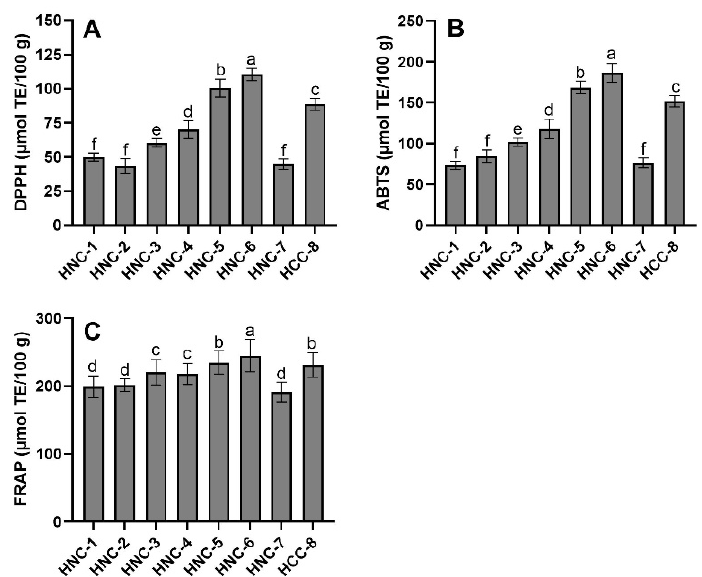
Figure 6. Antioxidant capacity of DPPH ( A ), ABTS ( B ), and FRAP ( C ) in fruits of eight genotypes of habanero pepper grown in the southeast of Coahuila. Values are the average of four replications. Means ( n = 4). Bars represent the standard deviation of the mean. Different letters in each bar mean that the genotypes were statistically different (Tukey, p ≤ 0.05).